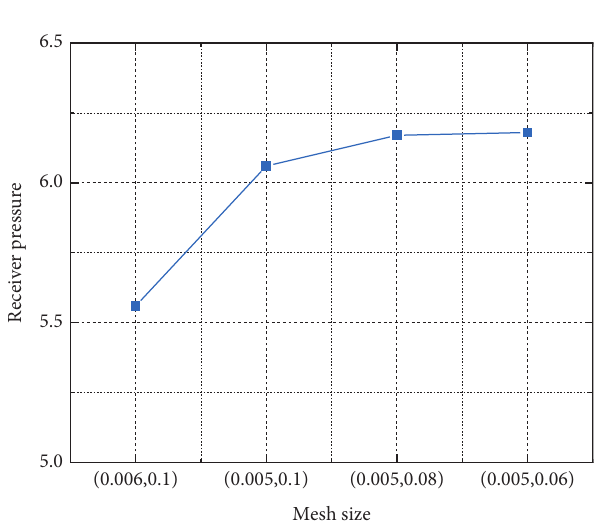
Figure 5: Receiver pressure at different mesh